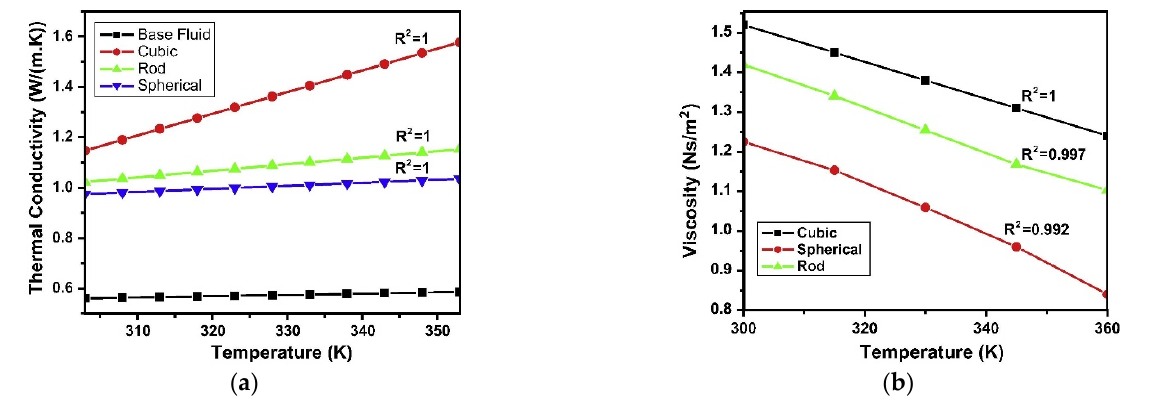
Figure 5. Effect of nanoparticle shape on ( a ) thermal conductivity and ( b ) viscosity [15].